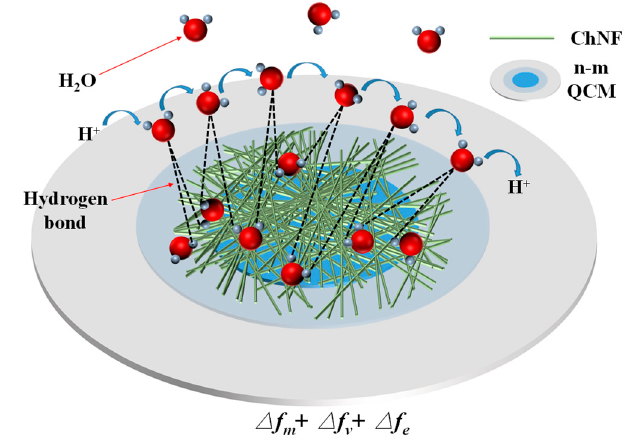
Figure 6. Schematic diagram of the humidity-sensitive mechanism of ChNFs-integrated n-m elec- QCM tode QCM sensors.